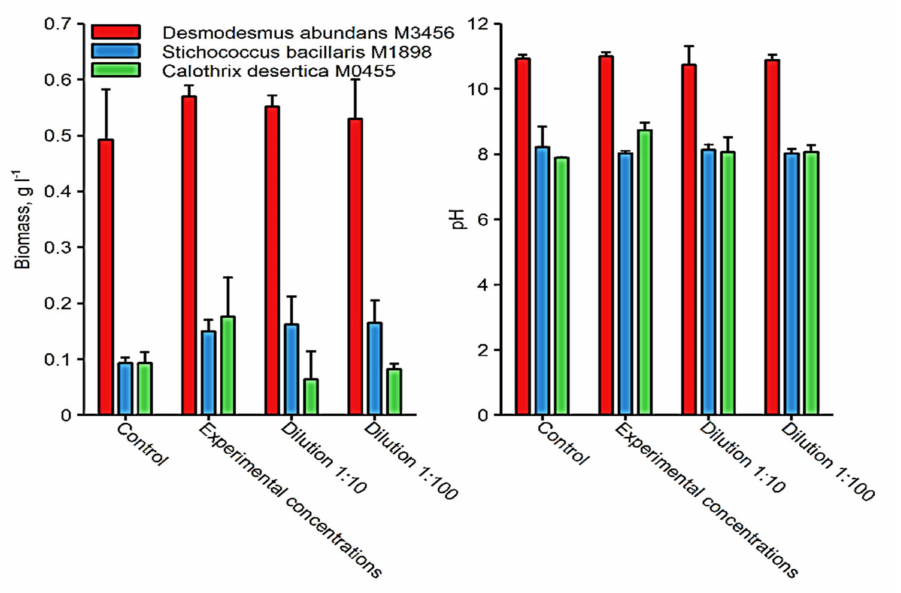
Figure 5. Average values of biomass and pH of different strains in diverse treatment